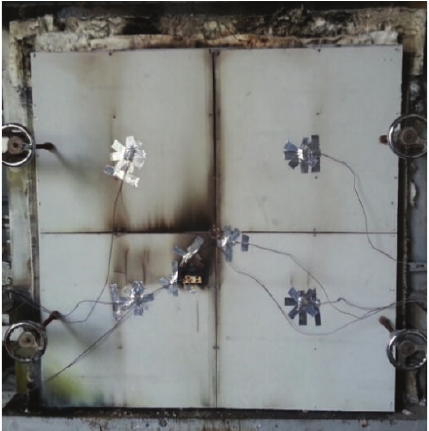
Figure 13: The result of the exposed surface of the specimen in Test 5.